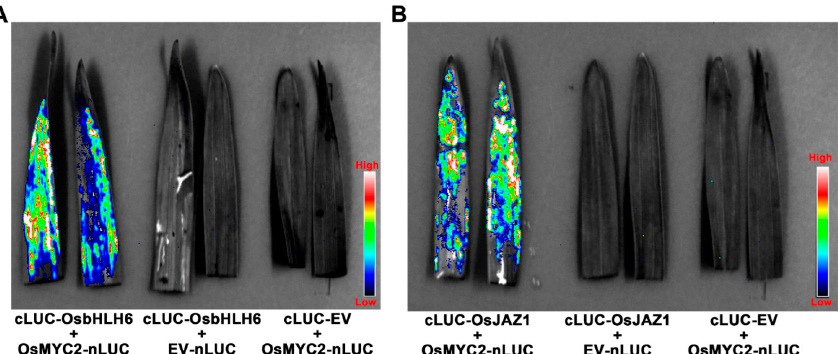
Figure 5. The optimized AMTE was amenable to Split-LUC assay of protein-protein interaction in barley (var. E9). The cLUC-OsbHLH6 and OsMYC2-Nluc ( A ) and the cLUC-OsJAZ1 and OsMYC2- Nluc ( B ) were transiently expressed in barley leaves. Samples were assayed at 4 dpi. Co-expressions with cLUC-EV or EV-nLUC were used as the control.